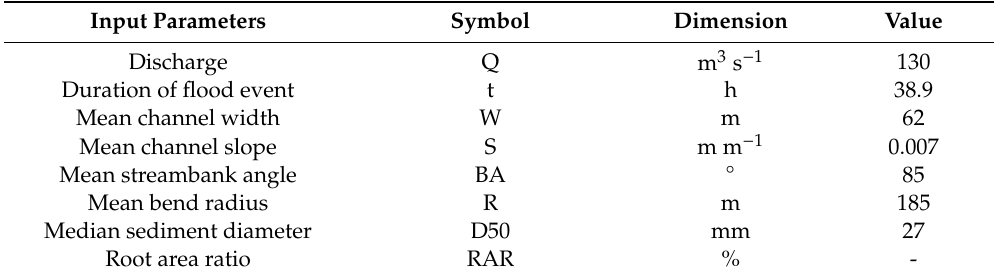
Table 2. Input parameters to perform BankforNET based on the analysis presented in Stecca et al. [28]. Input